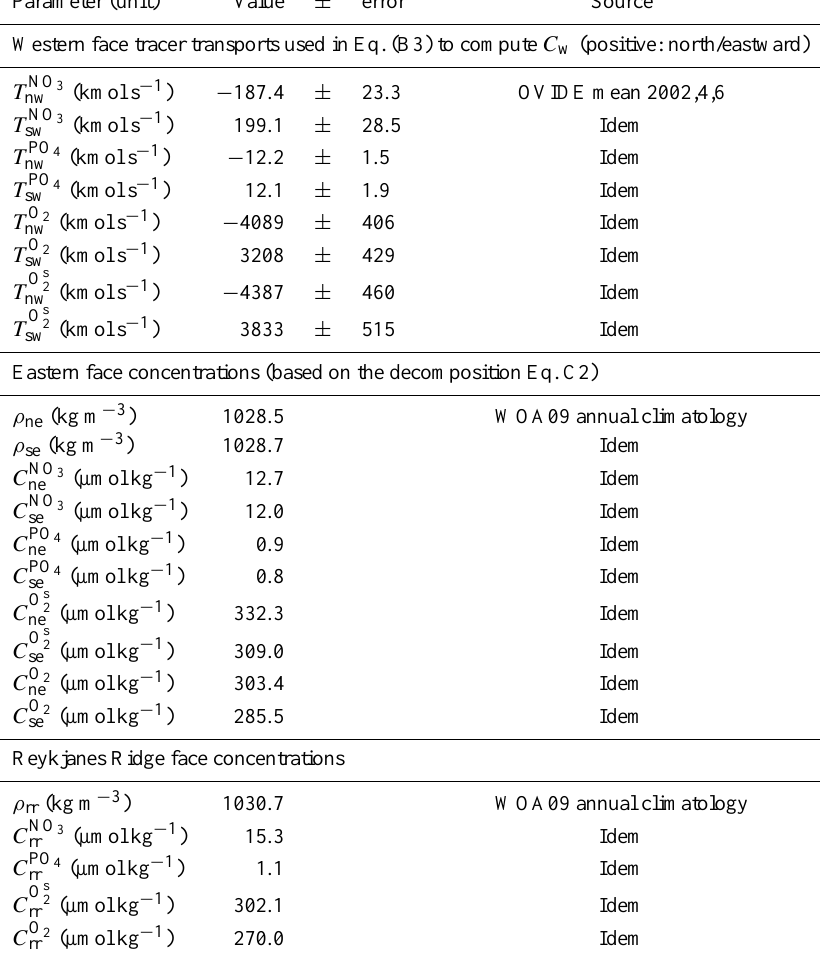
Table 2. Parameters used to compute budget terms but not optimized by the procedure. Parameter (unit) Value ± error Source Western face tracer transports used in Eq. (B3) to compute C w (positive: